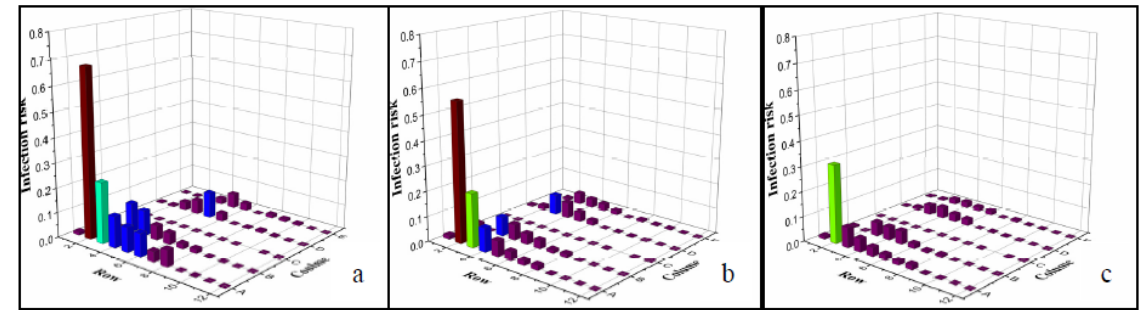
Figure 12. Infection risk of the passengers after a 4-h journey ( a ) Case 5 ( b ) Case 6 ( c ) Case 7.